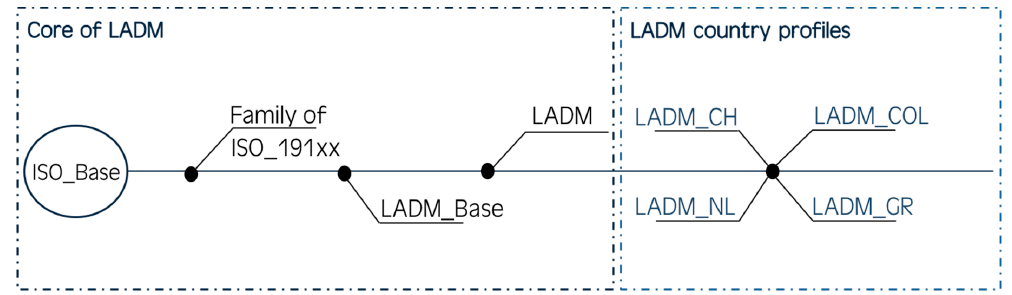
Figure 7. INTERLIS models used to describe LADM country profiles; country profiles that have been translated into INTERLIS language up until now.